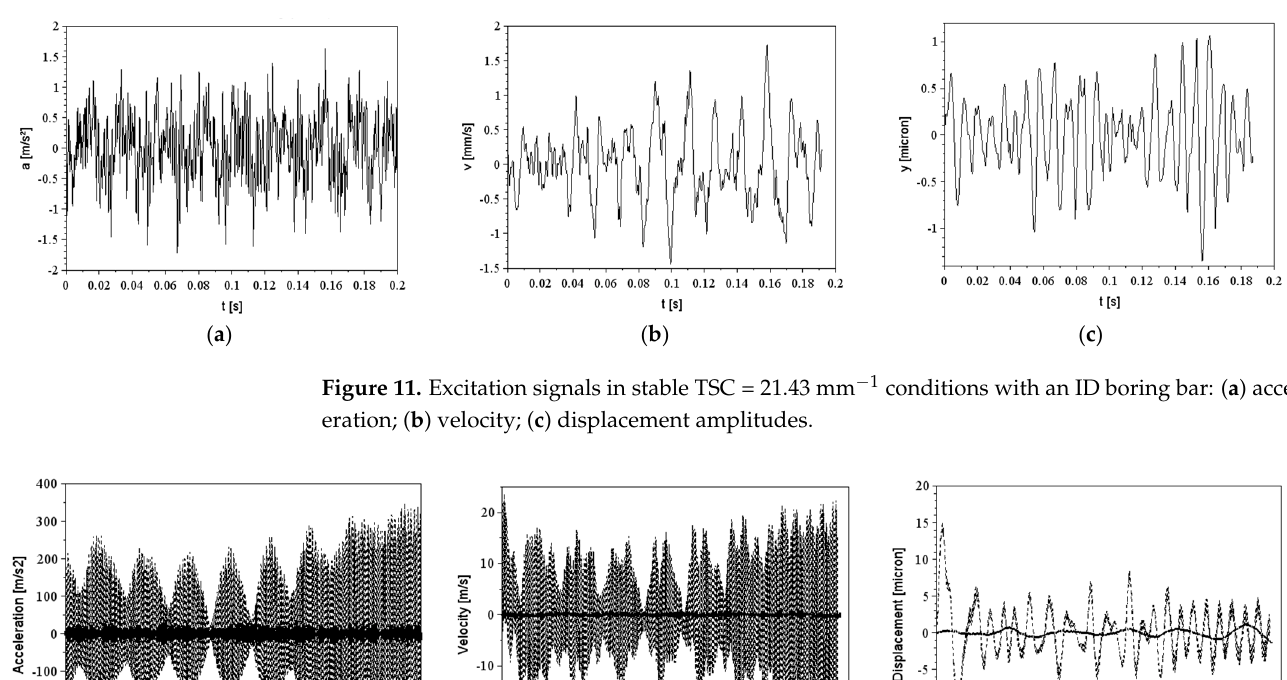
Figure 13. Excitation signals in stable TSC = 21.43 mm − 1 conditions with a carbide boring bar: ( a ) acceleration; ( b ) velocity; ( c ) displacement amplitudes.